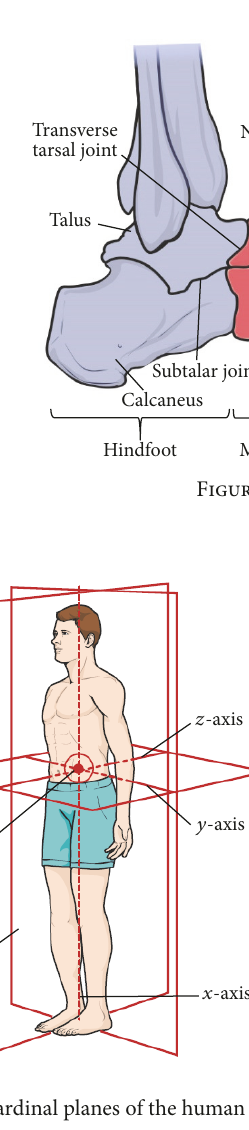
Figure 4: The three cardinal planes of the human body [45].